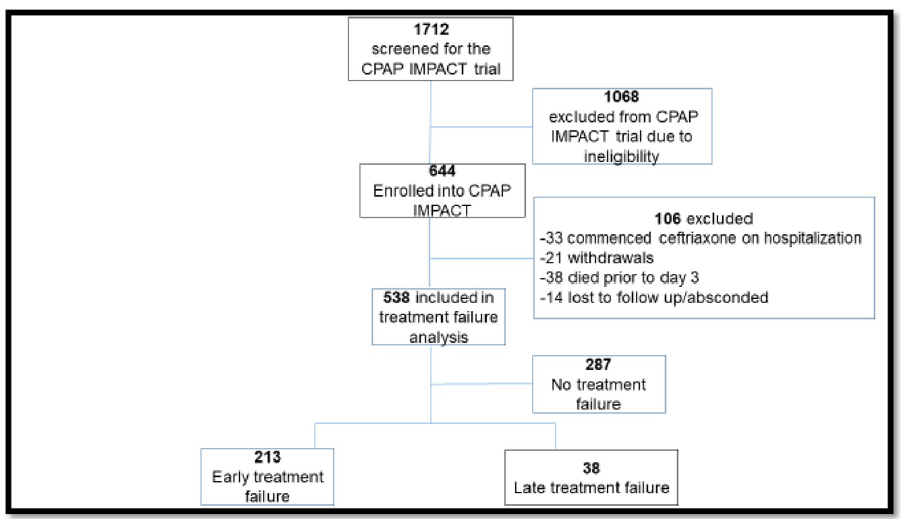
Fig 1. Consort diagram of CPAP IMPACT study participants analyzed for antibiotic treatment failure.